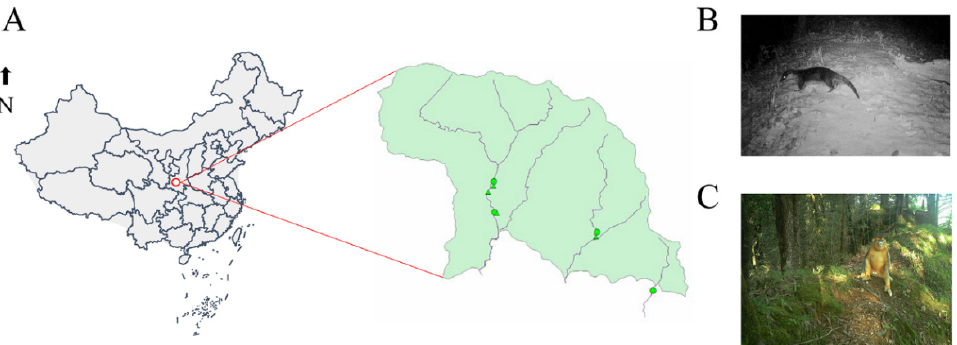
Figure 1. Map of Foping National Nature Reserve, China, highlighting the three field sites, including the sample collection locations (triangle: Otters; circle: Monkeys), separated by the river (blue line) ( A ); and photo of the study species, Eurasian otter ( Lutra lutra chinensis ) ( B ) and golden snub-nosed monkey ( Rhinopithecus roxellanae ) ( C ). Photos by Dapeng Zhu.